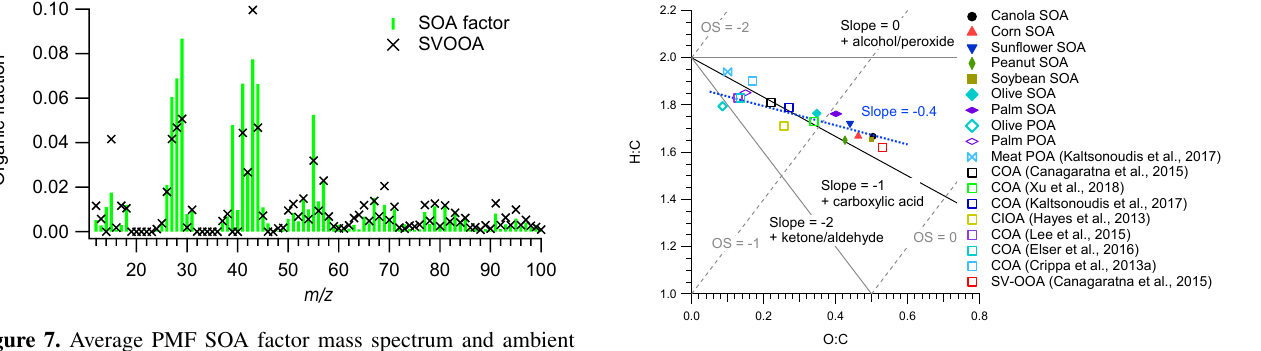
Figure 8. Van Krevelen diagram of POA and SOA from different cooking oils, as well as ambient PMF factors. Average carbon ox- idation states from Kroll et al. (2011) and functionalization slopes from Heald et al. (2010) are shown for